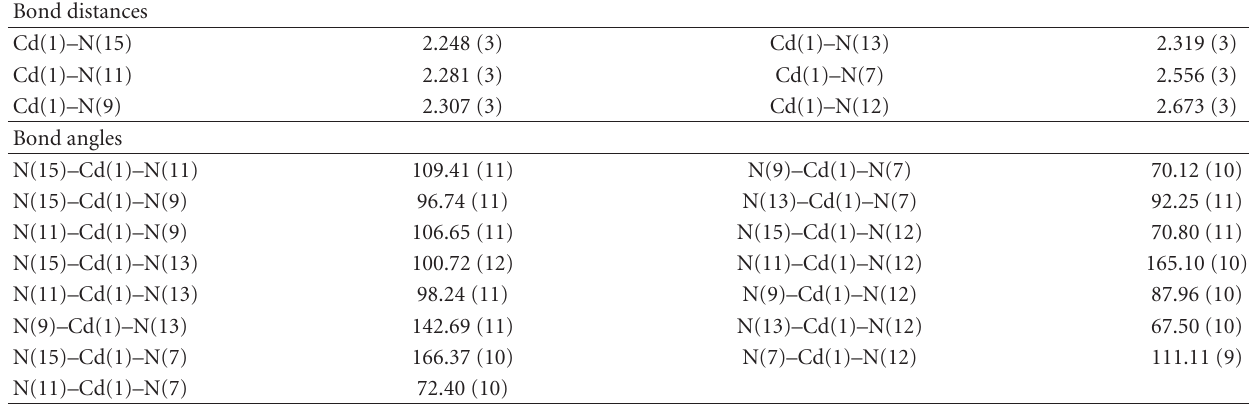
Table 2: Selected atomic distances (˚A) and bond angles ( ◦ ) for the